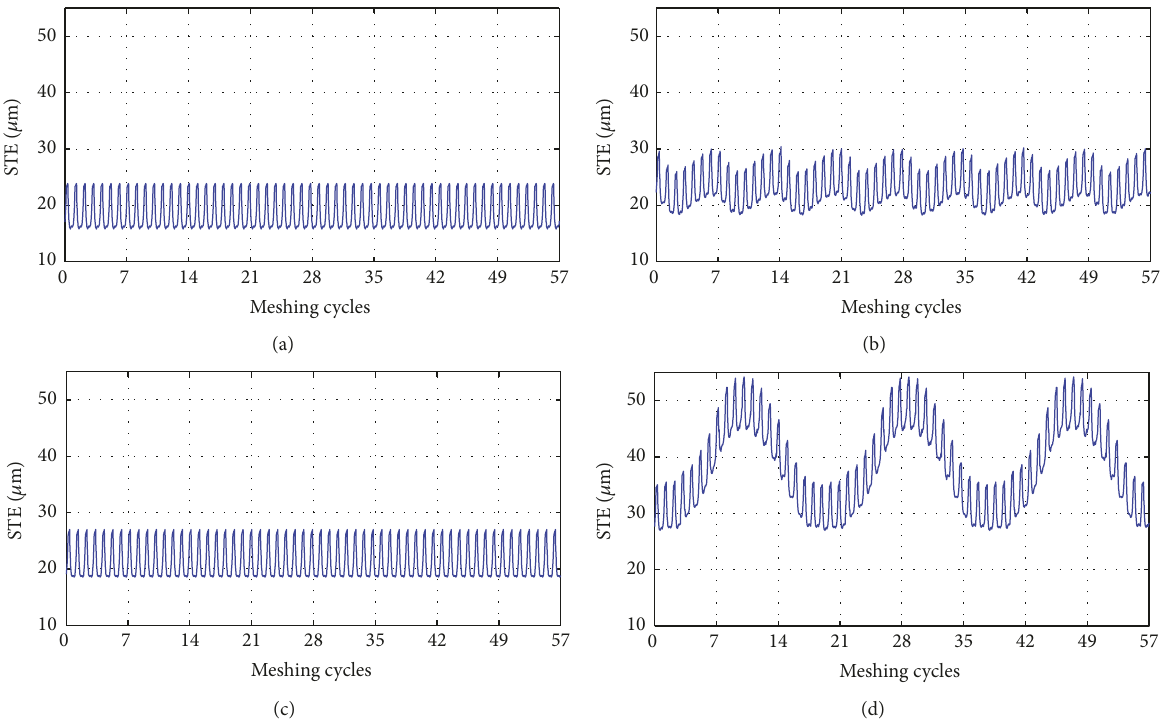
Figure 4: STE curves of the analysed gear pairs computed through nonlinear FE simulations for the gear pairs (a), (b), (c), and (d) in Figure